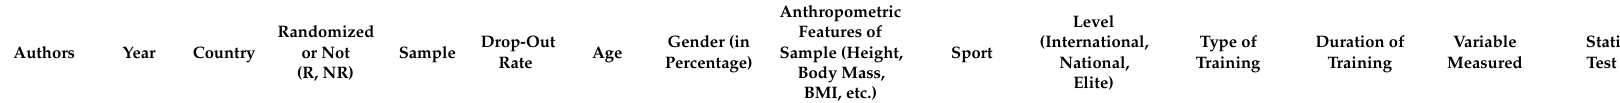
Table 2. Main characteristics of included